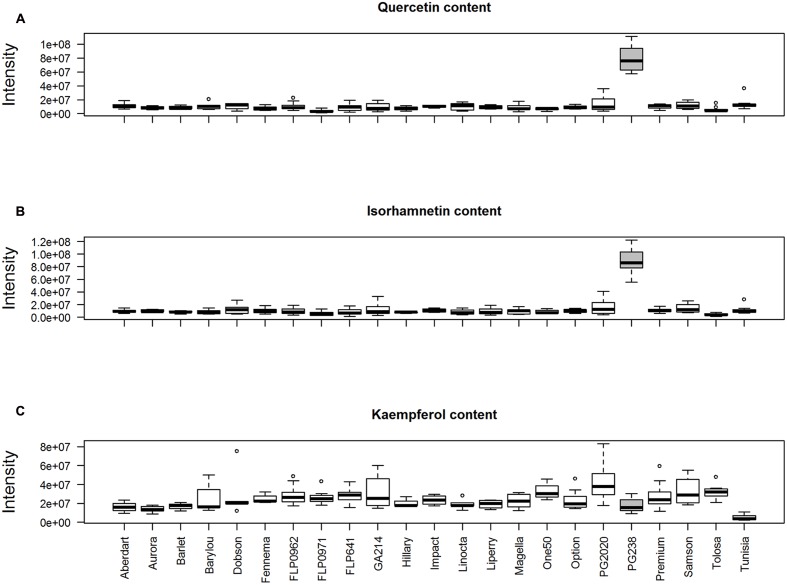
Peak aggregation analysis of
(A) quercetin ([M+H]+, 303.0499 m/z, 15 peaks); (B) isorhamnetin ([M+H]+, 317.0656 m/z, 15 peaks) and (C) kaempferol ([M+H]+, 287.0550 m/z, 23 peaks).